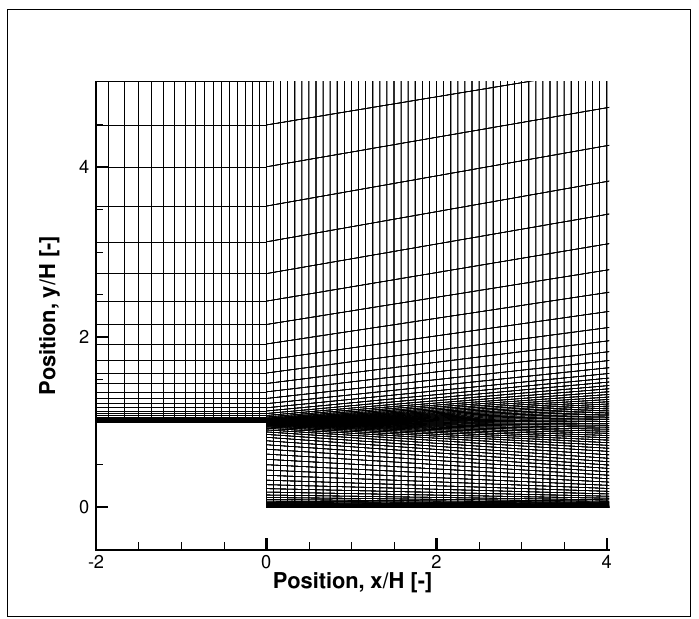
Figure 18. Detail of backward-facing step mesh.